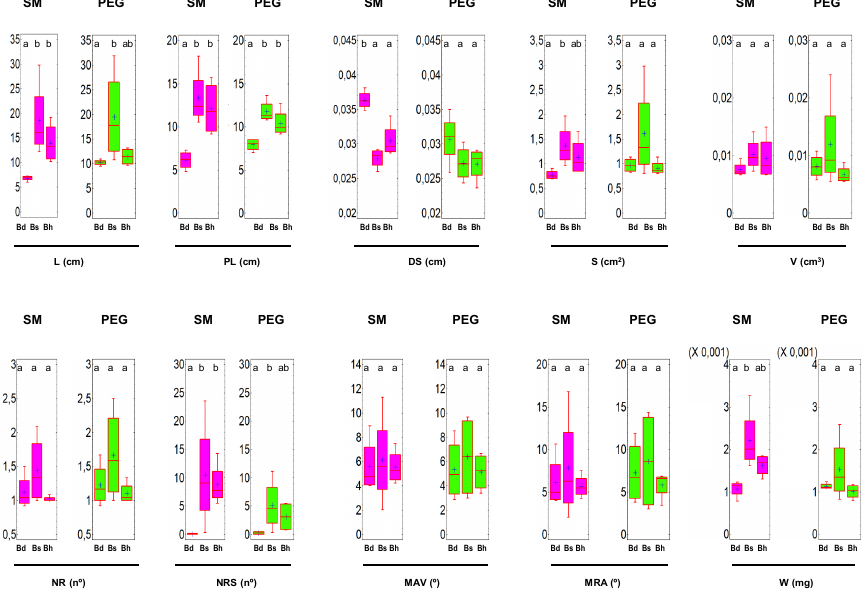
Figure 1. Box ‐ plot of the RSA variables and W for each Brachypodium species in the two culture media. L: total root length in cm, S: total surface area of the roots in cm 2 , V: total roots volume in cm 3 , DS: mean diameter of the seminal roots in cm, PL: primary root length in cm, NR: number of seminal roots, NRS: number of secondary roots, MAV: the minimum seminal root angle with respect to the vertical, MRA: mean of all seminal root angles with respect to the vertical, W: dry weight of the shoots in mg. Different letters indicate statistical significance at p < 0.05 level of probability.